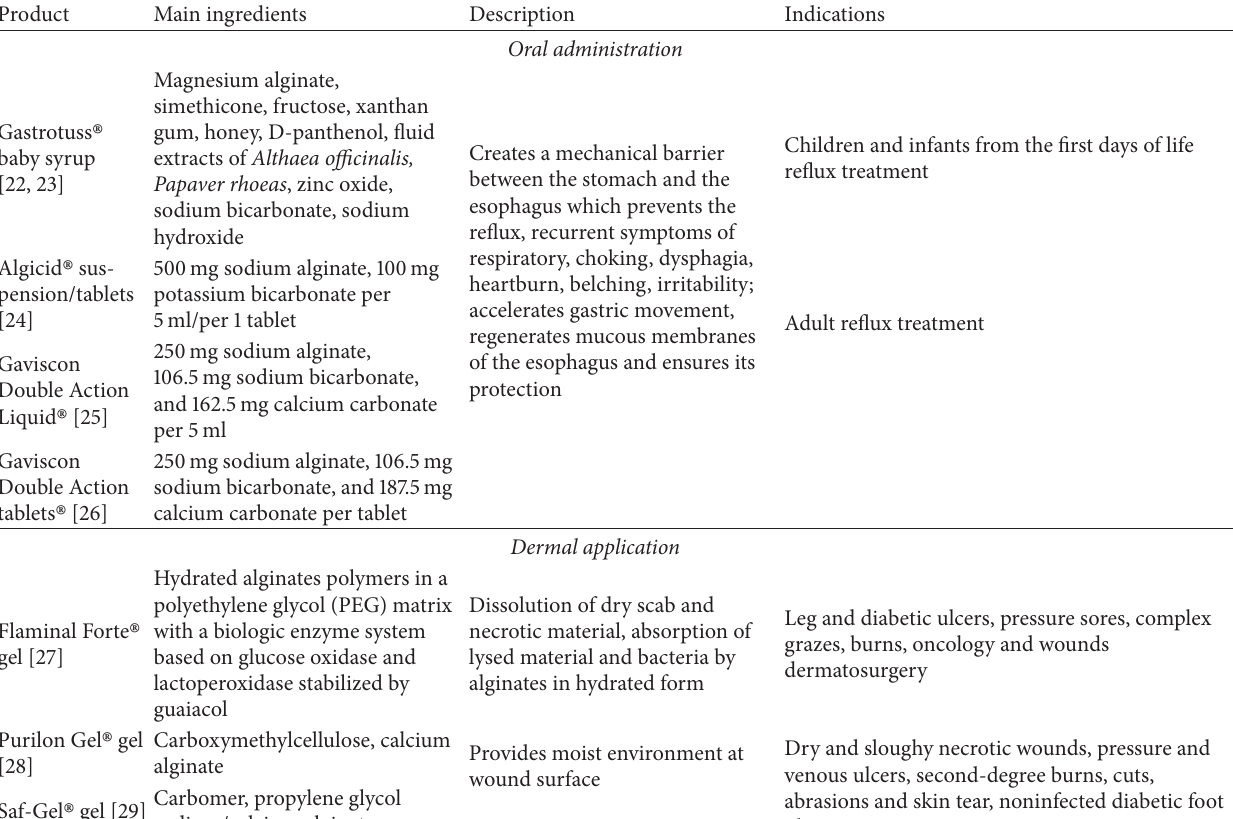
Table 4: List of the pharmaceutical products based on